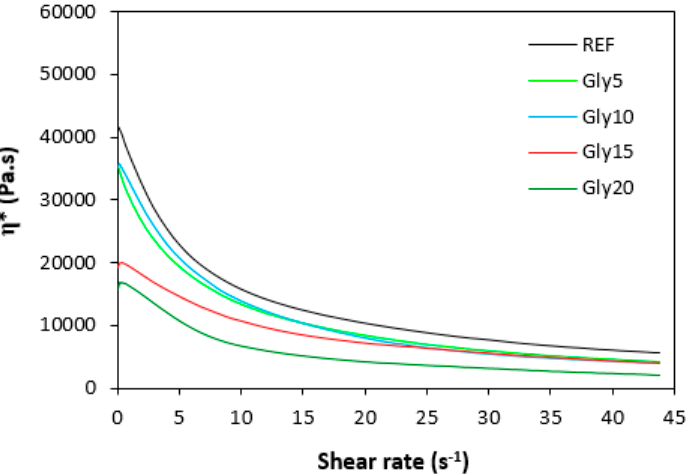
Figure 9. Dependence of dynamic complex viscosity ( η *) of rubber compounds based on SBR on shear rate.